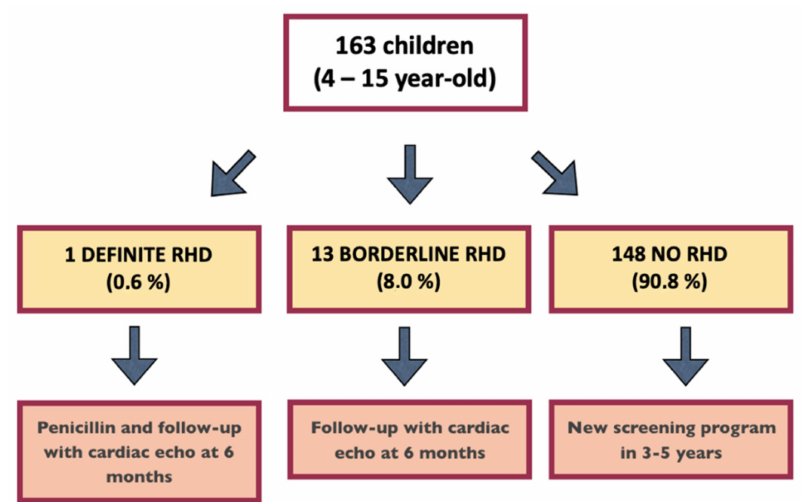
Figure 3. RHD screening summary and follow-up advice. The figure shows the results of the RHD screening, and the adopted follow-up strategy, as suggested by the WHO guidelines [8]. One patient is missing in the count since echocardiography was not feasible (see the Section 3. Results).